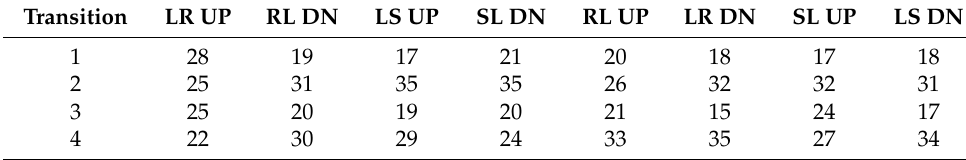
Table 3. Percentage of different gait phases over a complete gait cycle (%).